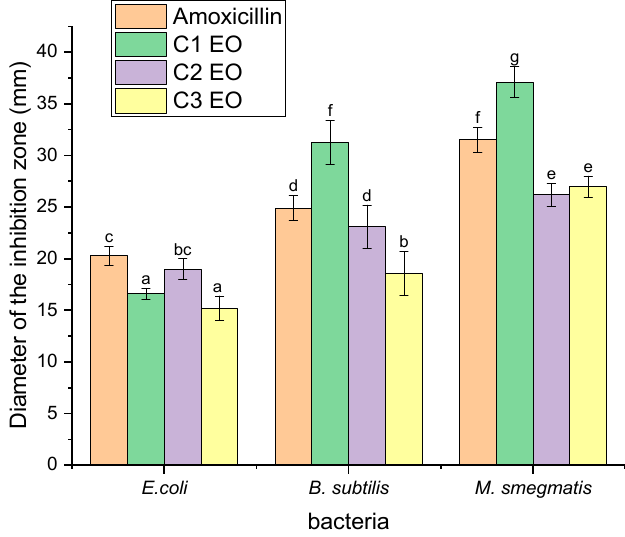
Figure 6. Diameter of inhibition zones of three bacteria strains as a function of the essential oils from the three cooperatives. Each column represented by different letters (a, b, c, d, e, f, and g) represent a significant difference ( p < 0.05) based on Tukey test. Cn EO: essential oil from different coopera- tives.